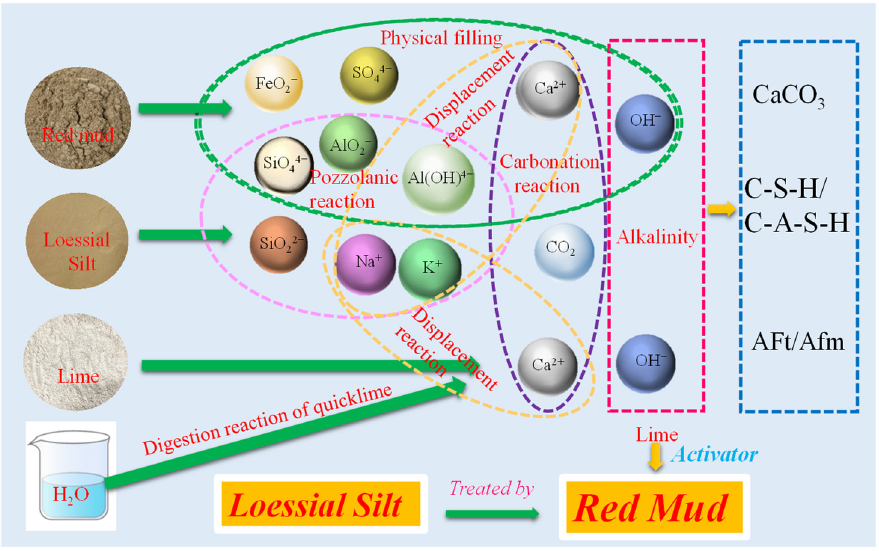
Figure 24. Schematic diagram of the